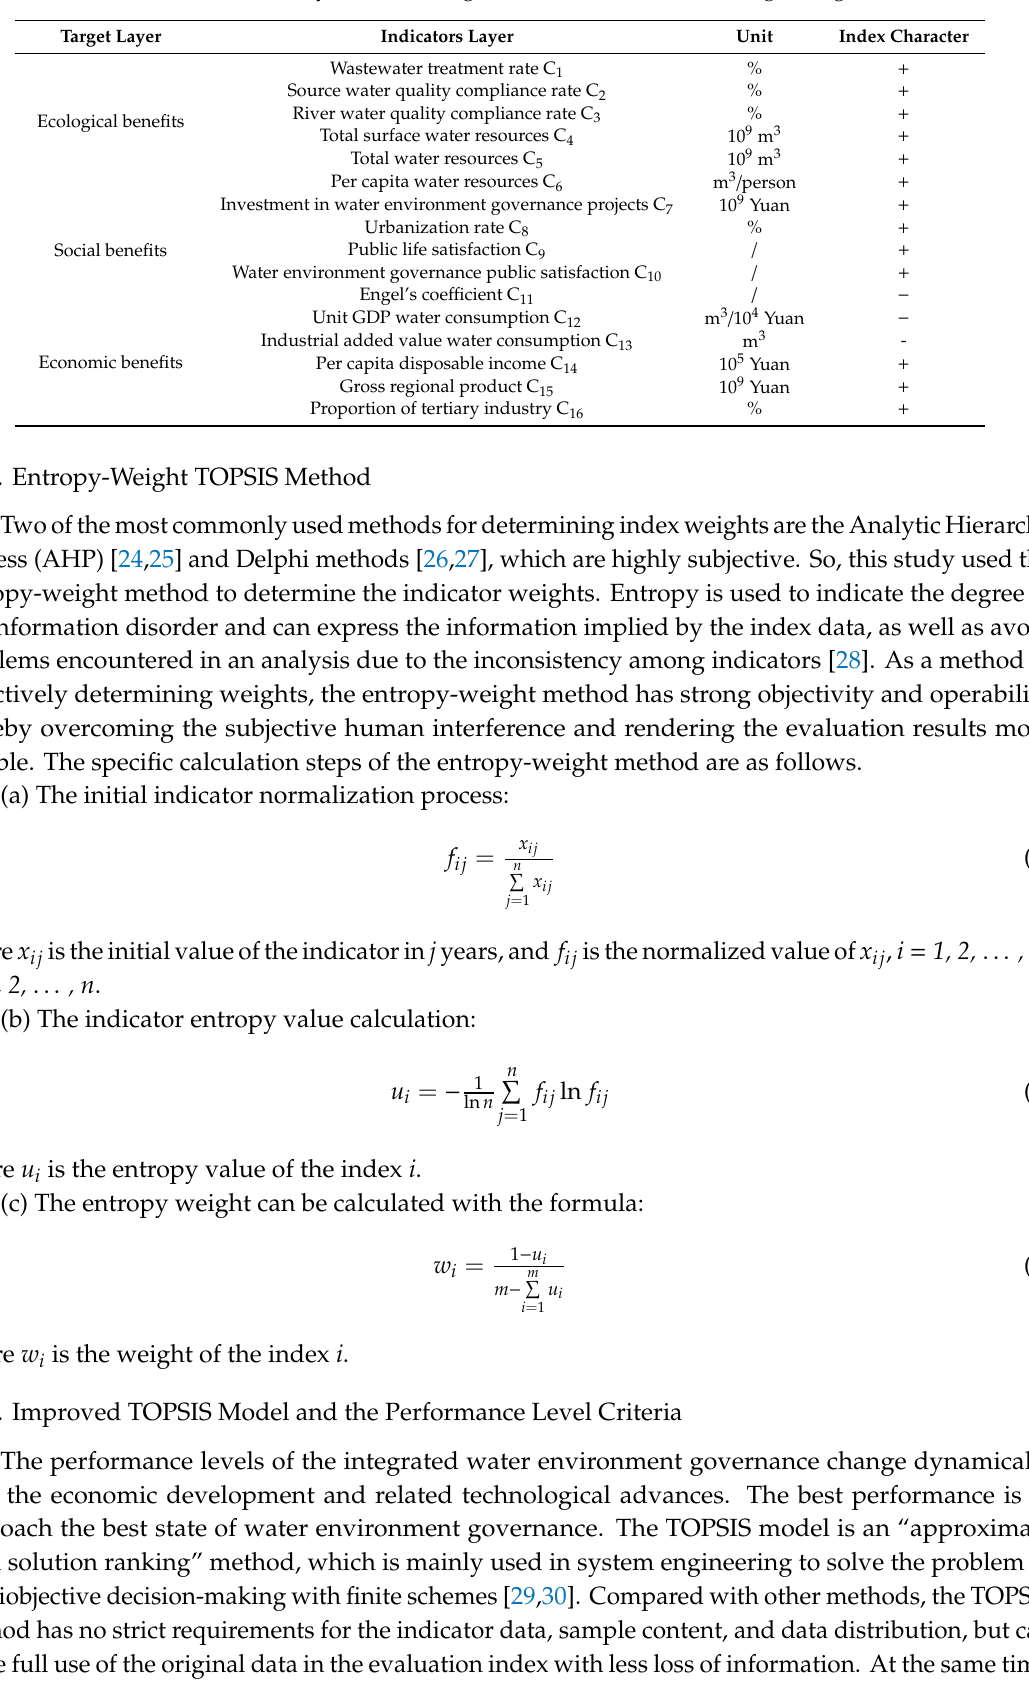
Table 1. Evaluation index system of the regional water environment integrated